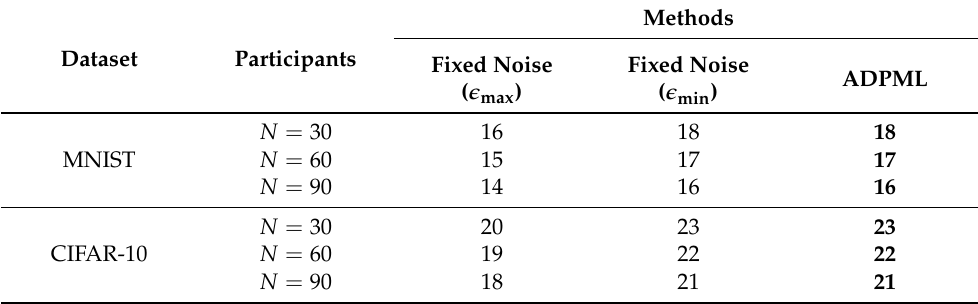
Figure 5. The total privacy budget of different noise addition strategies for 30, 60, and 90 participants. Table 2. The communication round of different strategies for 30, 60, and 90